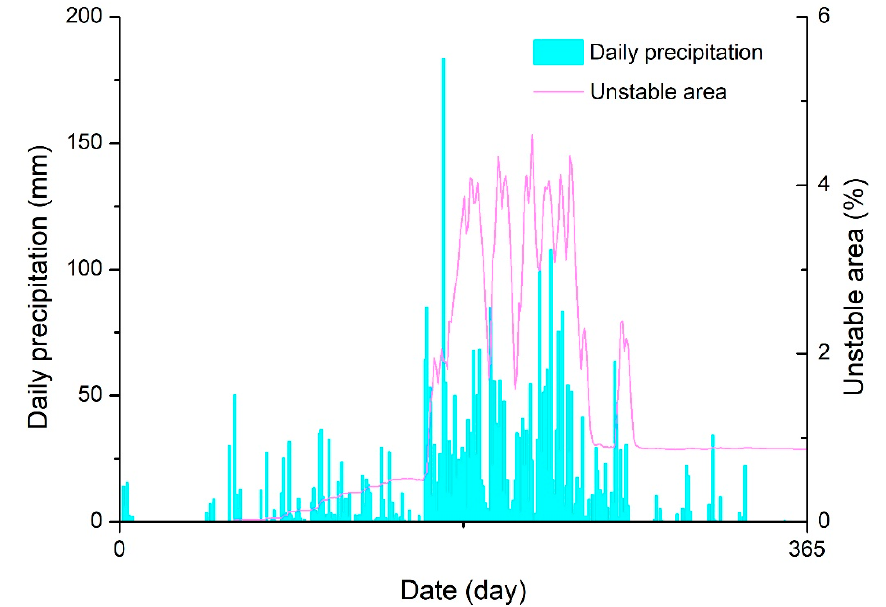
Figure 5. 2016 daily rainfall and corresponding unstable area percentage